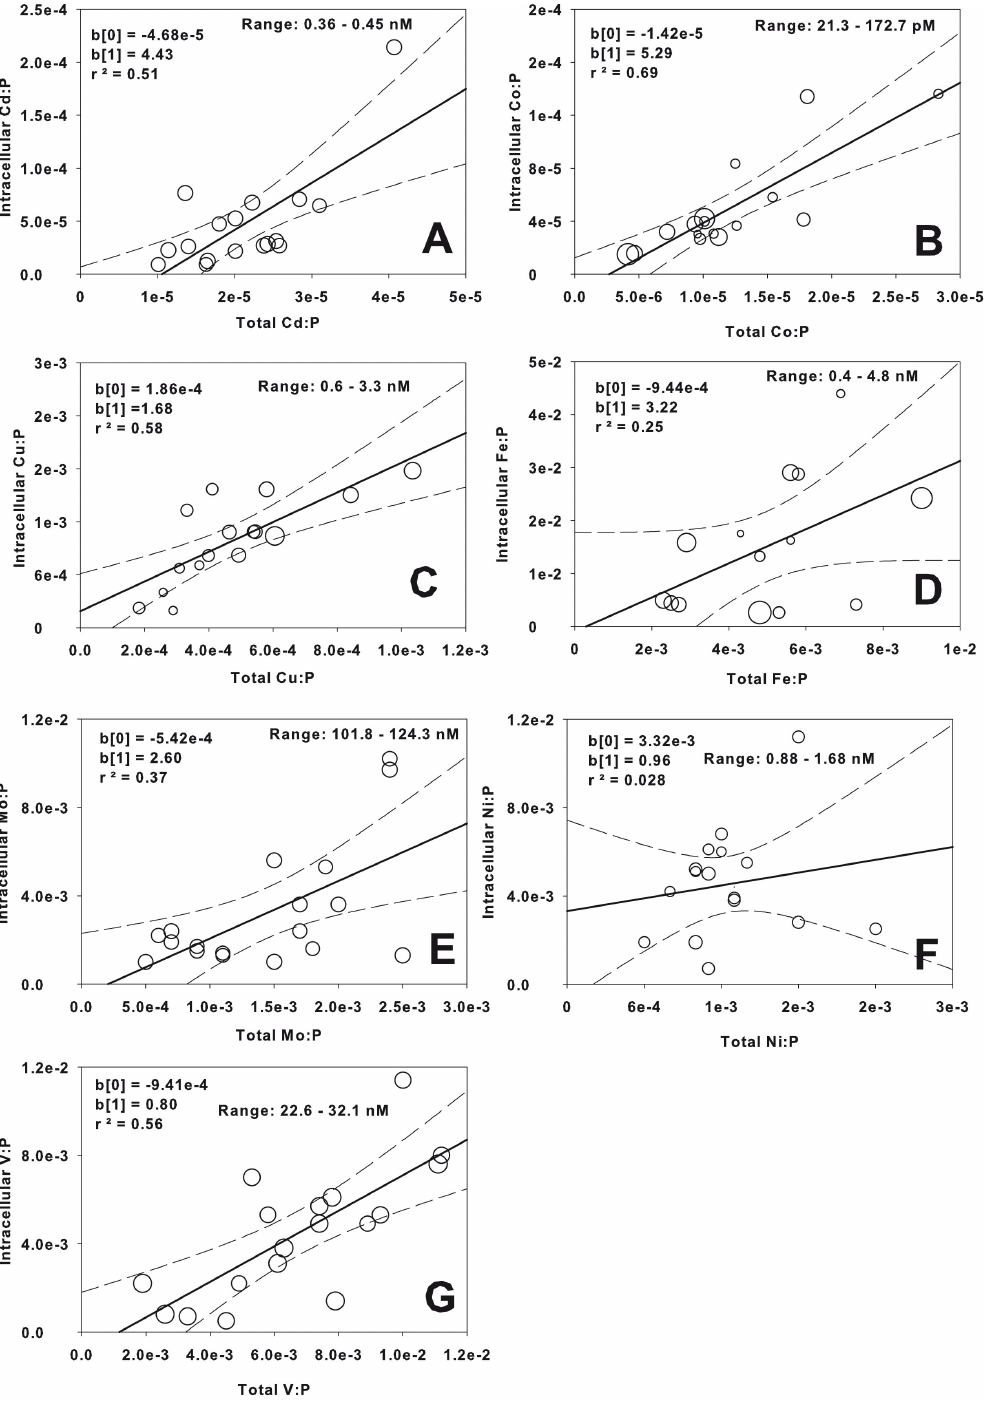
Fig. 4. Bubble plots showing the relationship between total and intracellular metal composition measured in the field colonies of Tri- chodesmium (all metal data normalized to P). The size of the open circles is proportional to the dissolved metal concentrations measured in surface waters where the colonies were collected. The solid line represents the linear regressions obtained among the two biological metal pools and the dashed lines are the 95th confidence limits. The range of dissolved metal levels measured during our study is also shown in each